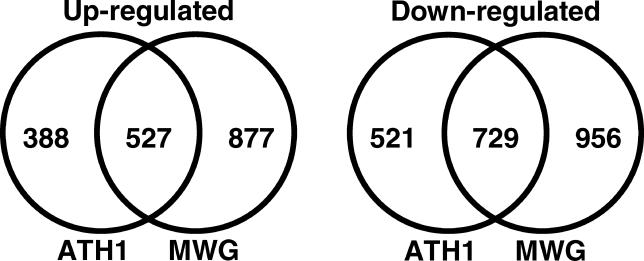
Comparison of Significant Expression Changes between the ATH1 and MWG ArraysVenn diagrams showing the overlap between genes detected as significantly (FDR p < 0.05) up- or down-regulated using data from the ATH1 and the MWG arrays. Only data for the 20,159 genes that are represented by probes on both arrays are shown.